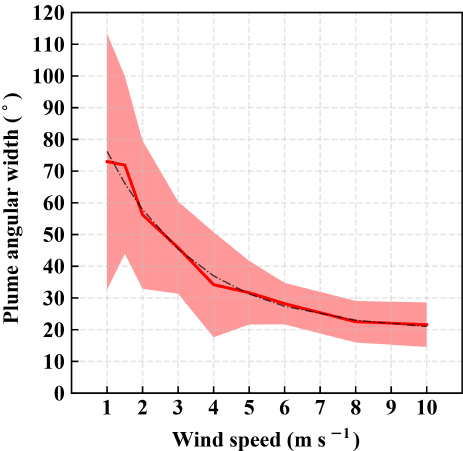
Figure 10. Relationship between the wind speed and the associated cone width averaged over snapshots and flux rates. The dotted black curve represents the best fit by an exponential function. The shaded area represents 1 standard deviation from the mean plume angular width for each wind speed.